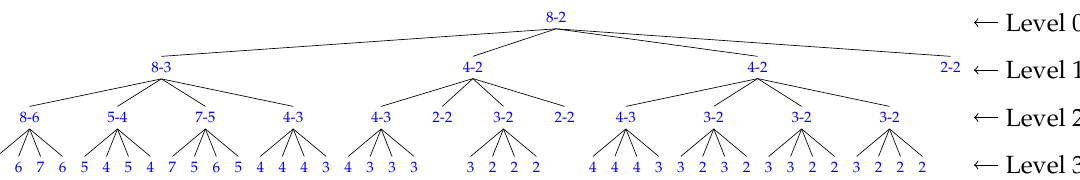
Figure 2. Subdivision of an example 8 × 8 matrix for k 2 -raster ( k = 2).